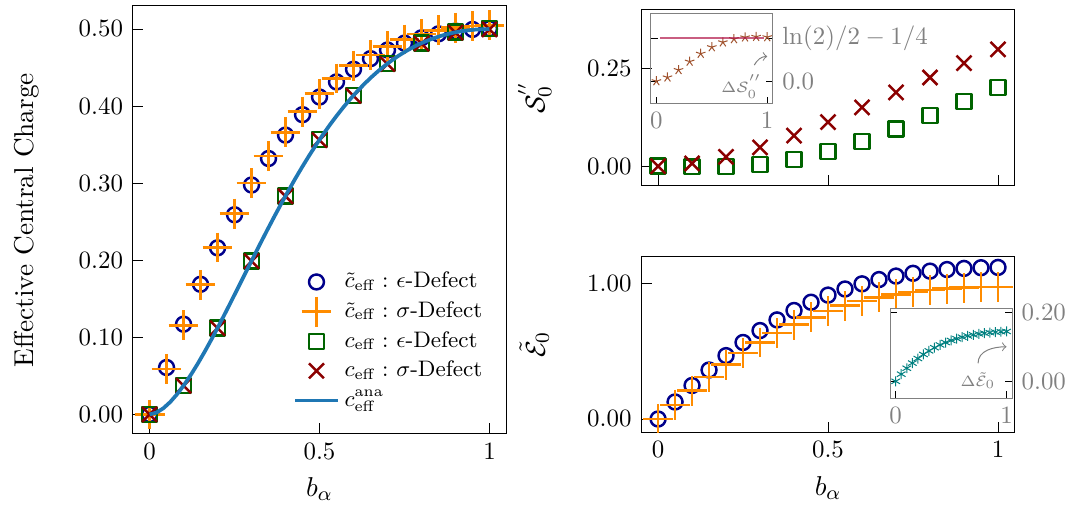
Figure 7 . Variation of the effective central charges (left) and the sub-leading corrections (right) with the defect strength for the energy and duality defects. The effective central charges, c eff , obtained from the scaling of the interface EE, S I , for the energy and duality defects are identical for a given defect strength and are compatible with the predictions of eq. (3.8), denoted in this plot by c ana . The computed values ˜ c eff from the log-EN again agree in between the defects of eff equal strength. The subleading corrections on the right increase with their difference (shown in the respective inserts) eventually saturating towards a fixed value. For the interface EE, this offset ∆ S 00 is in good agreement with the analytic prediction for b σ = 1 of eq. (3.9), shown as the pink 0 line. The corresponding subleading corrections for the log-EN are shown in the bottom right